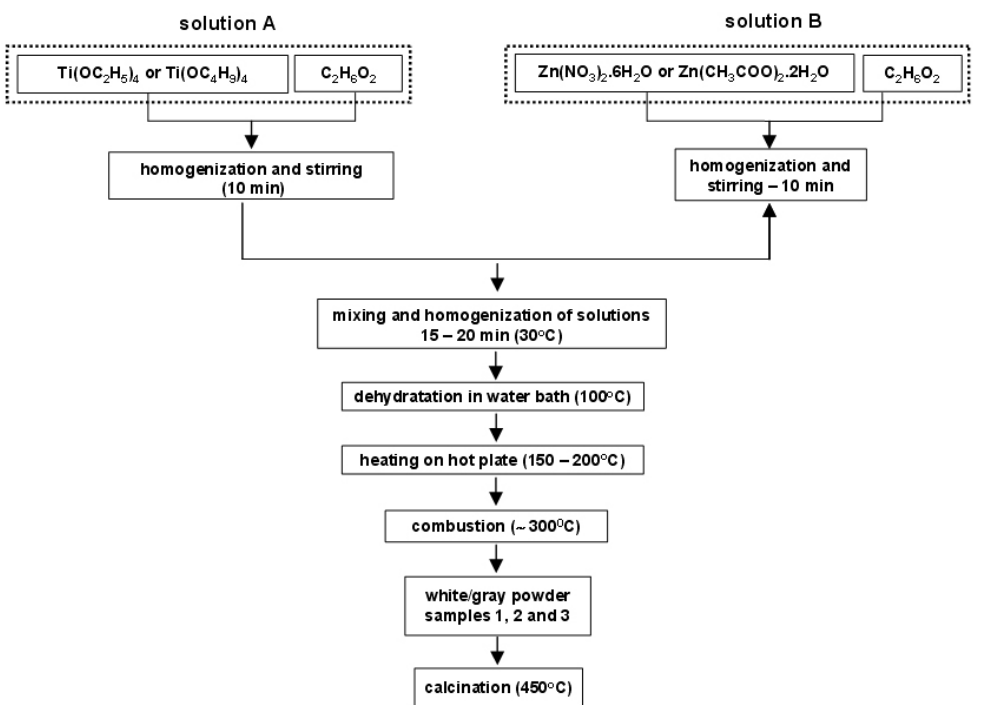
Figure 1. Scheme for combustion gel synthesis of ZnO/TiO